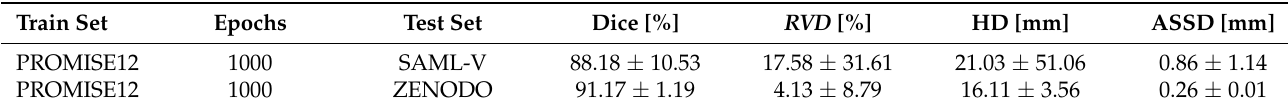
Table 2. Quantitative metrics results for MRI prostate segmentation with nnU-Net. Performance has been measured on two validation sets.